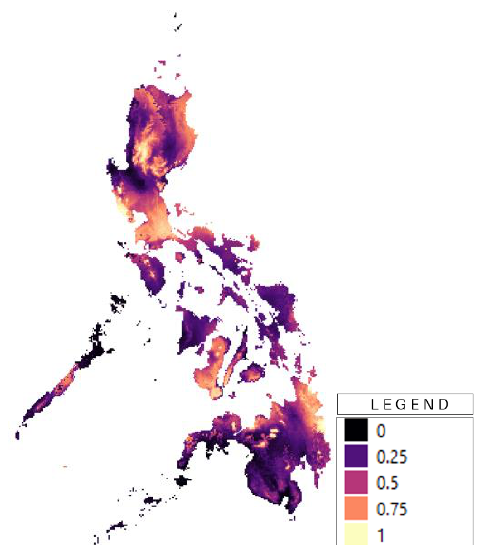
Figure 5. Visualized prediction of Maxent for C. manillensis There were 771 occurrence data points for C. manillensis . This allowed the splitting of the data into a training set and test set with a 70:30 split. The sensitivity and specificity graph for this model together with its AUC is shown below. The graph shows good and acceptable performance for the model. The AUC for the train and test set differ by a considerable amount which is likely due to the fitness of C. manillensis to a wide range of climatic conditions in the Philippines.